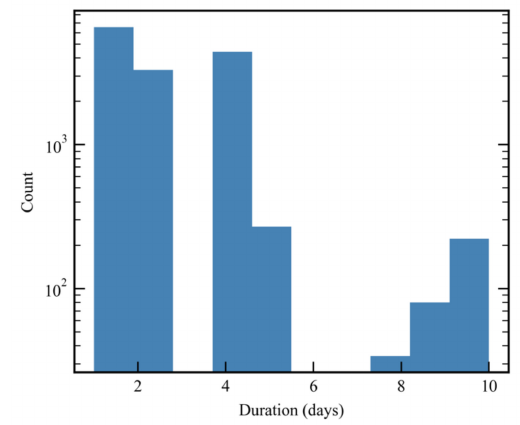
Figure 5. The frequency of pond sizes from the gap-filled classification for 6 May 2017, indicates that the distribution of ponds is heavily skewed towards small ponds. Frequencies are shown on a base-10 log-log scale.